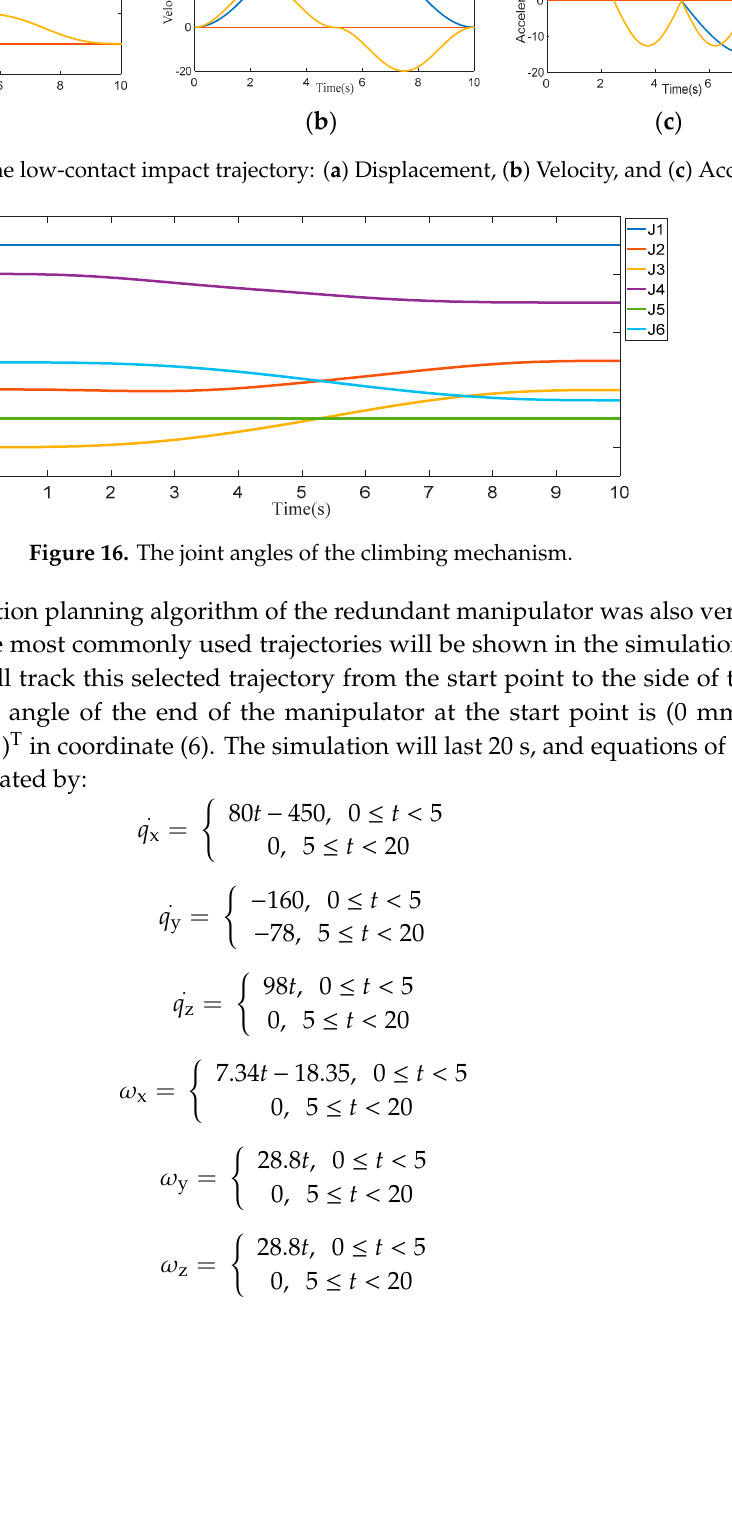
Figure 17. The position of the end of the manipulator in the simulation. 0